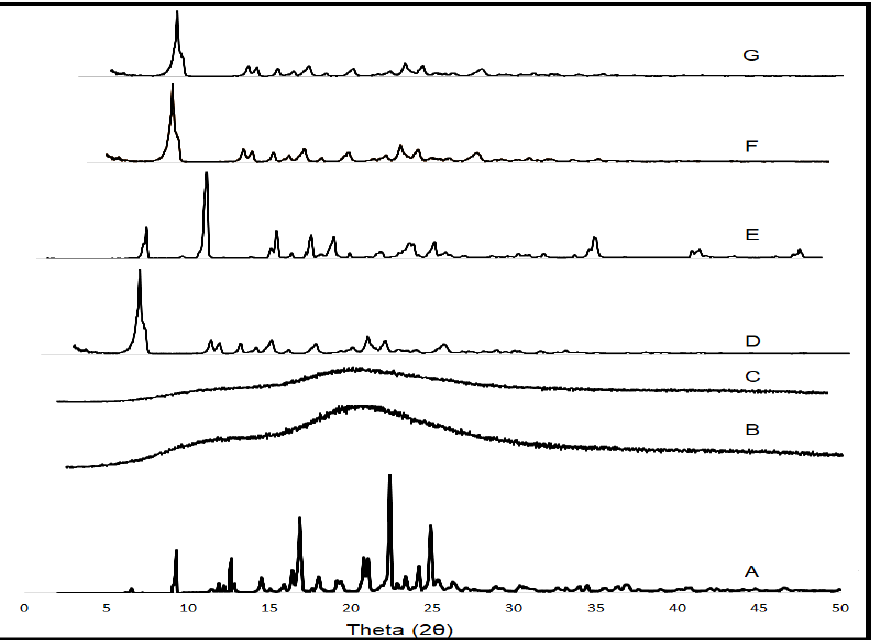
Figure 5. X-ray diffraction patterns of (A) IR, (B) HP-βCD, (C) IR-HP-βCD inclusion complex (1:1 molar ratio), (D) Dynasan 112, (E) IR + Dynasan 112 physical mixture, (F) lyophilized IR-SLN2 formulation, and (G) lyophilized IR-HP-βCD-SLN2 formulation.